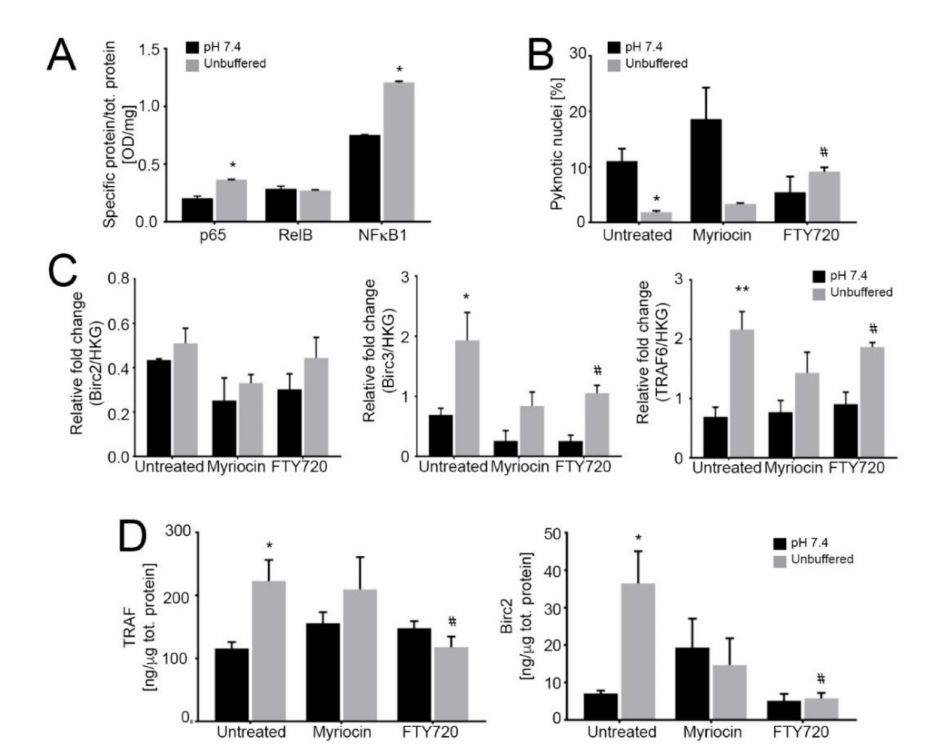
Figure 4. Activation of the noncanonical NF- κ B pathway dramatically reduces tumor growth under acidic conditions. ( A ) Quantification of nuclear NF- κ B proteins relative to total protein as an indicator of nuclear translocation and activation in 143B spheroids cultured for 96 h at pH 7.4 or in unbuffered conditions. Data are presented as the mean ± S.E.M. of n = 6 samples from 3 independent experiments; unpaired two-tailed Mann-Whitney test; * p < 0.05 for unbuffered vs neutral; ( B ) Percentage of pyknotic nuclei to total nuclei in 143B spheroids cultured for 96 h in neutral or unbuffered conditions. Data are presented as the mean ± S.E.M. of n = 6 samples from 3 independent experiments; unpaired two-tailed Mann-Whitney test; * p < 0.05 for unbuffered vs neutral, # p < 0.05 vs untreated at the respective pH condition; ( C ) Real Time PCR analysis of the indicated genes normalized to 4 housekeeping genes (HKG; GAPDH, GUSB, RNA18S, and YWAHZ) in 143B spheroids treated with 0.75 µ M myriocin and 0.15 µ M FTY720 and cultured for 96 h in neutral or unbuffered conditions. Data are presented as the mean ± S.E.M. of n = 6 RNA samples from 3 independent experiments; unpaired two-tailed Mann-Whitney test; * p < 0.05 and ** p < 0.01 for unbuffered vs neutral, # p < 0.05 vs. untreated at the respective pH condition; ( D ) ELISA quantification of TRAF and BIRC proteins expressed as ng/ µ g total protein in cultured 143B spheroids treated as indicated for 96 h. Data are presented as the mean ± S.E.M. of n = 6 replicates from 3 independent experiments; unpaired two-tailed Mann-Whitney test; * p < 0.05 for unbuffered vs neutral, # p < 0.05 vs. untreated at the respective pH